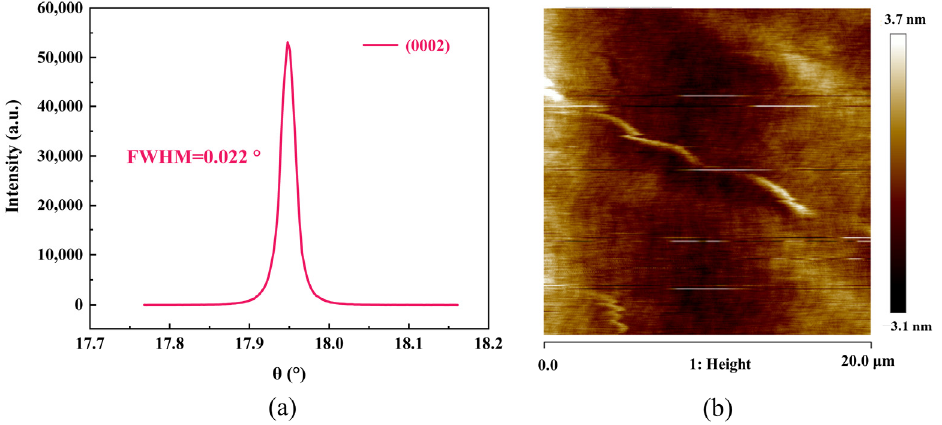
Figure 2. ( a ) XRD spectrum from the Single Crystal AlN piezoelectric film grown by MOCVD, ( b ) surface AFM image of the AlN film.